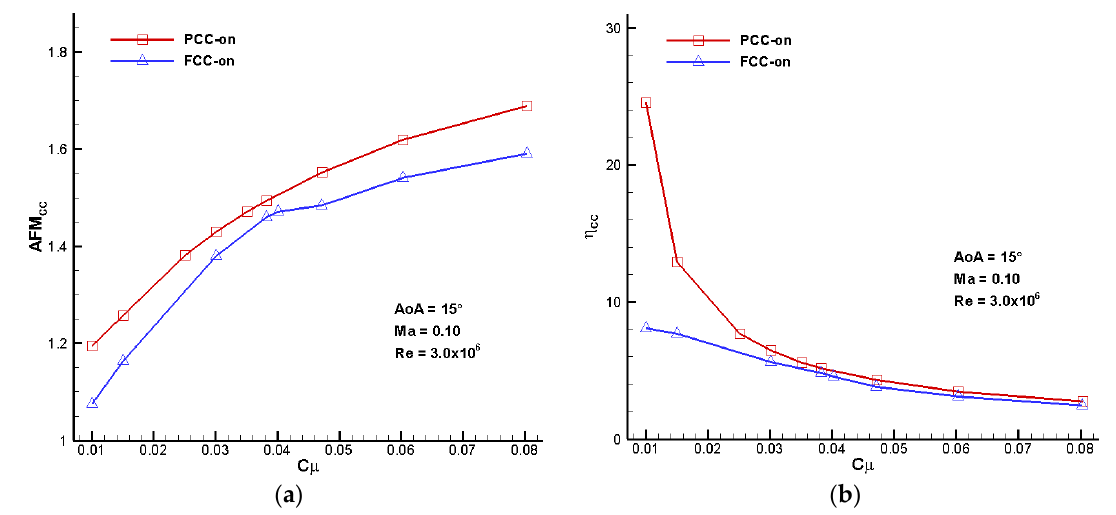
Figure 16. Comparisons of aerodynamic figure of merit and control efficiency: ( a ) Aerodynamic figure of merit; ( b ) Circulation control efficiency.